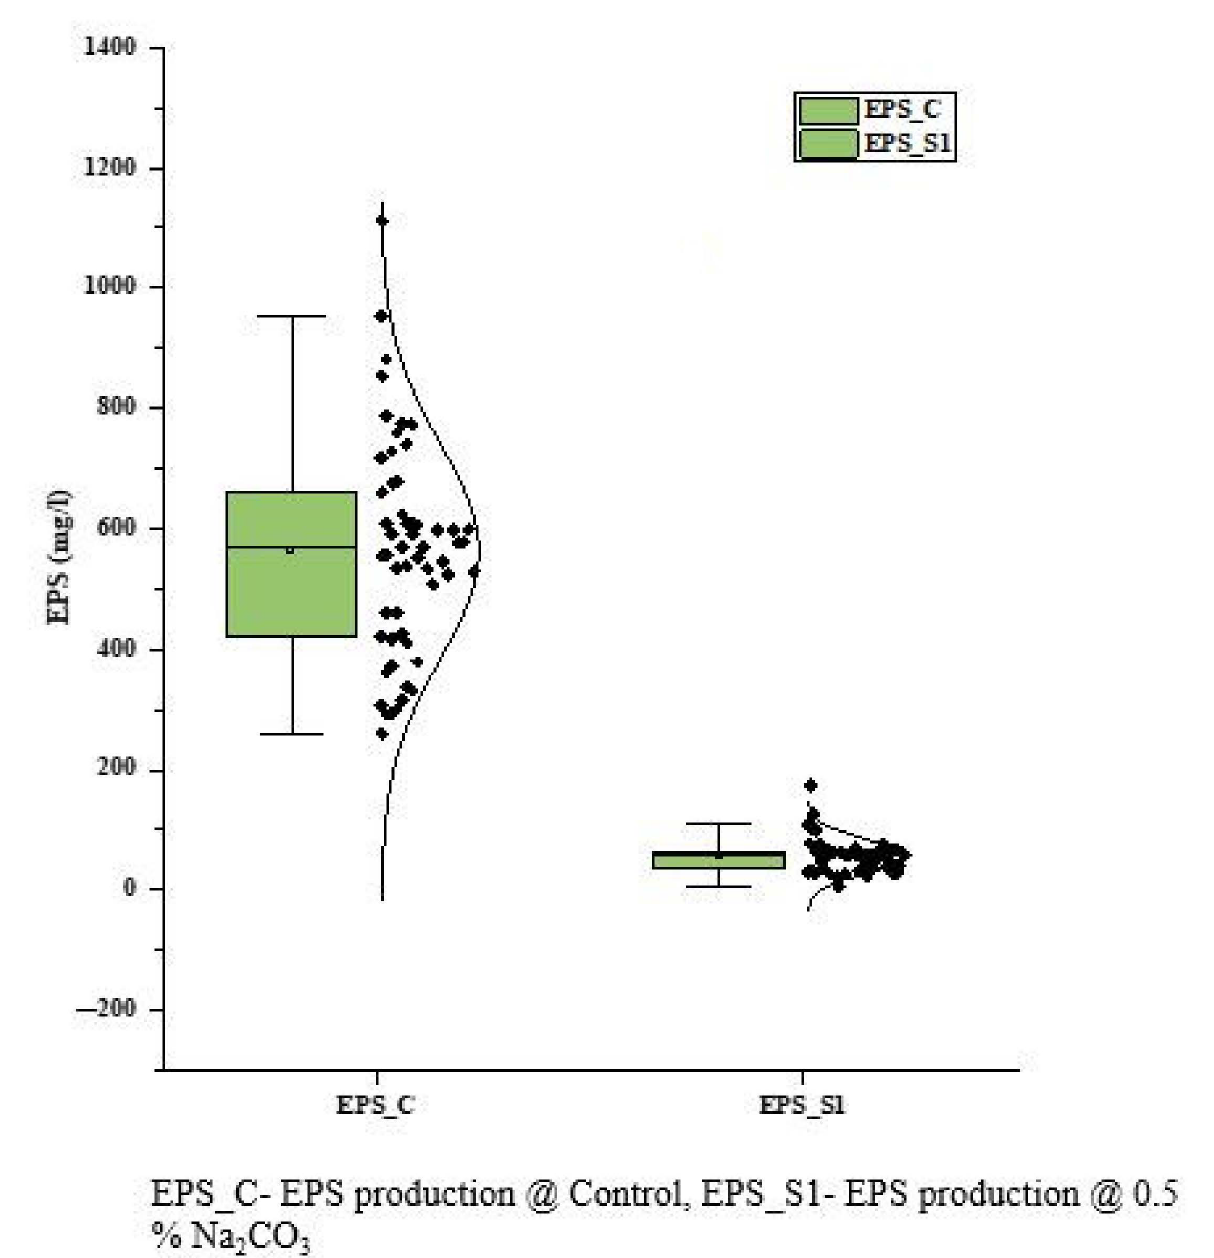
Figure 2. Distribution of bacterial EPS production at stressed and unstressed conditions. EPS_C—EPS production for control; EPS_S1—EPS production at 0.5% Na 2 CO 3